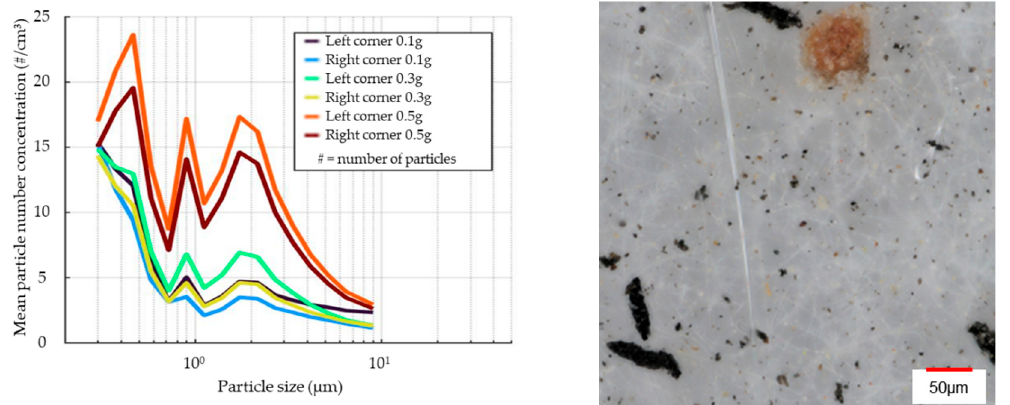
Figure 8. Comparison of the particle size distribution of TRWP collected at the test track and illustration of the collected particles on filter pads.